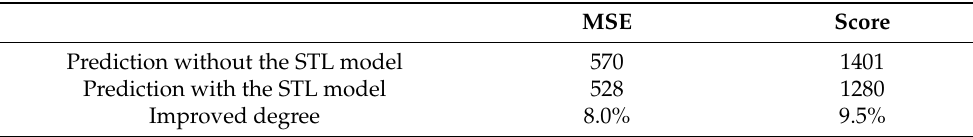
Table 4. RUL prediction